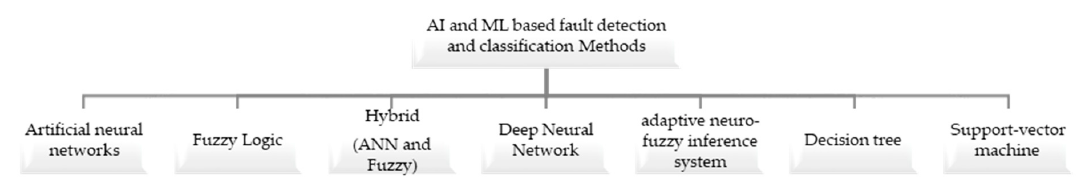
Figure 4. Knowledge-based fault detection and classification (FDC) techniques.